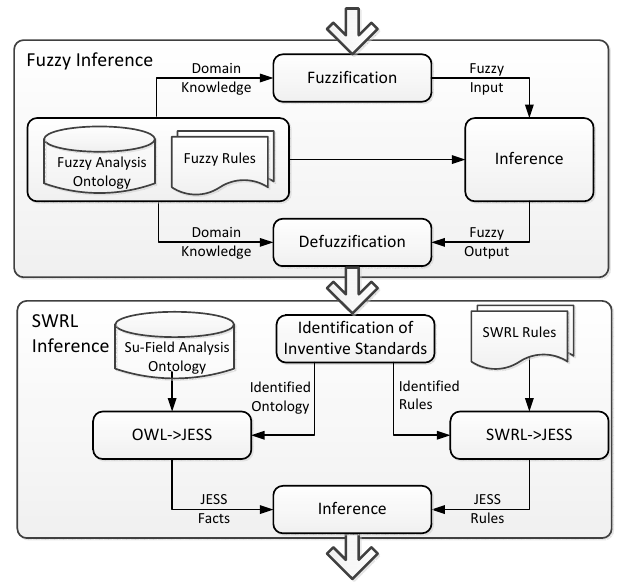
Figure 2. The architecture of an intelligent system heuristic Su-Field